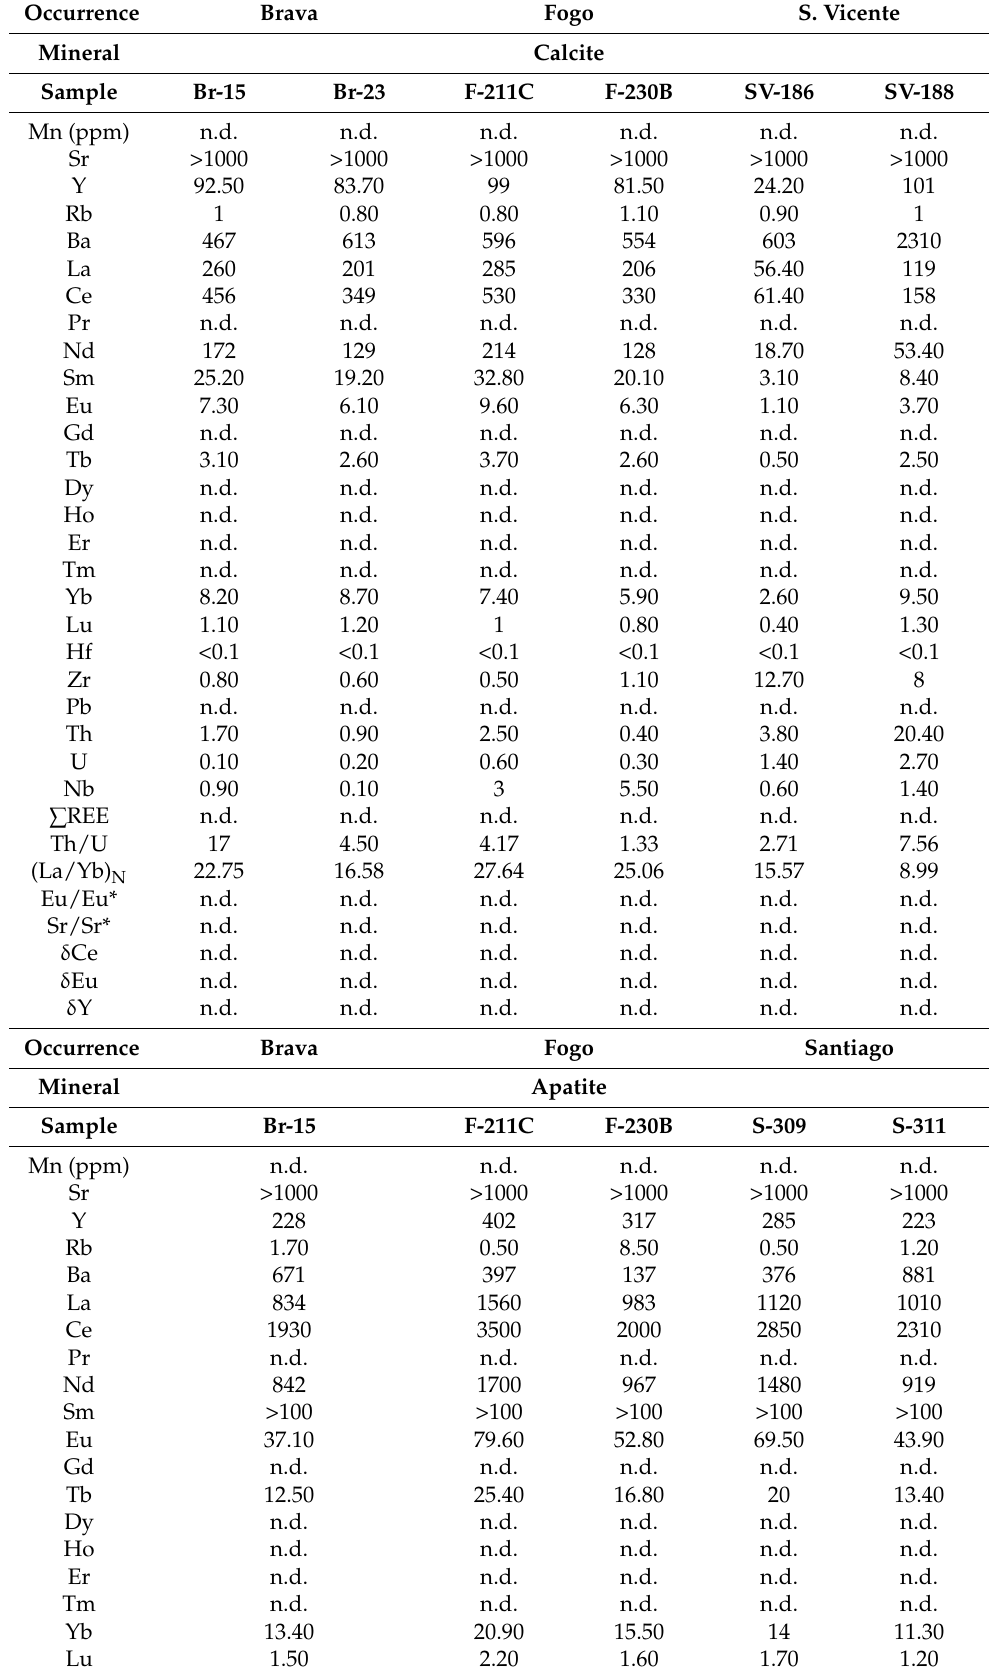
Table A2. Literature trace element compositions of calcite and apatite in Cape Verde carbonatites.